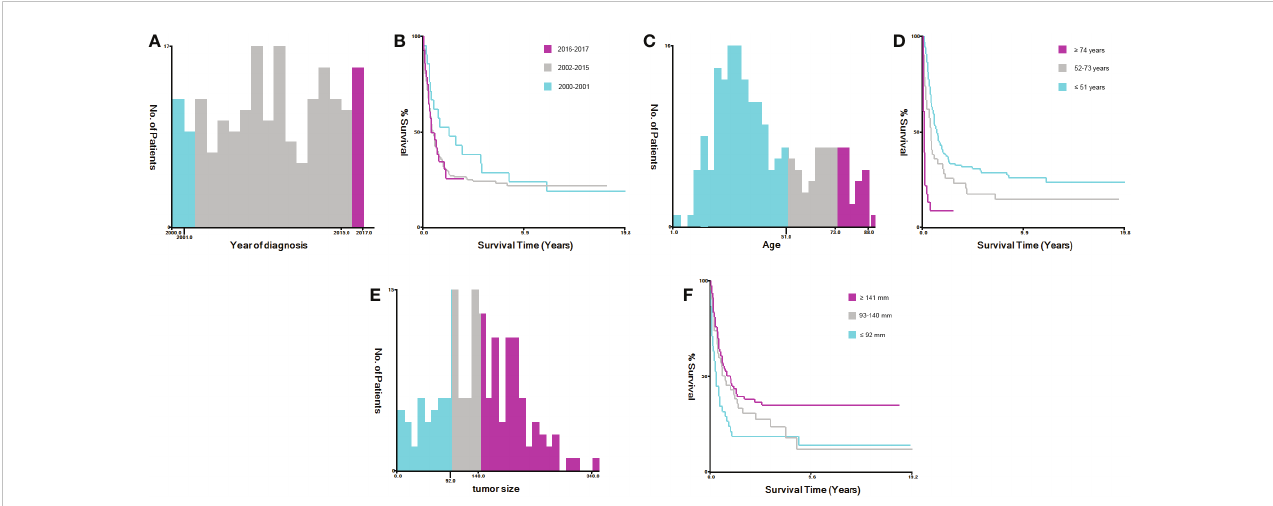
FIGURE 2 Identi fi cation of optimal cut-off values for year of diagnosis, age and tumor size via X-tile software analysis. (A, B) Optimal minimum and maximum cut- off value 2001 and 2005 for year of diagnosis and its survival curves. (C, D) Optimal minimum and maximum cut-off values 57 and 73 years for age and its survival curves. (E, F) Optimal minimum and maximum cut-off value 59 and 176 mm for tumor size and its survival curves.